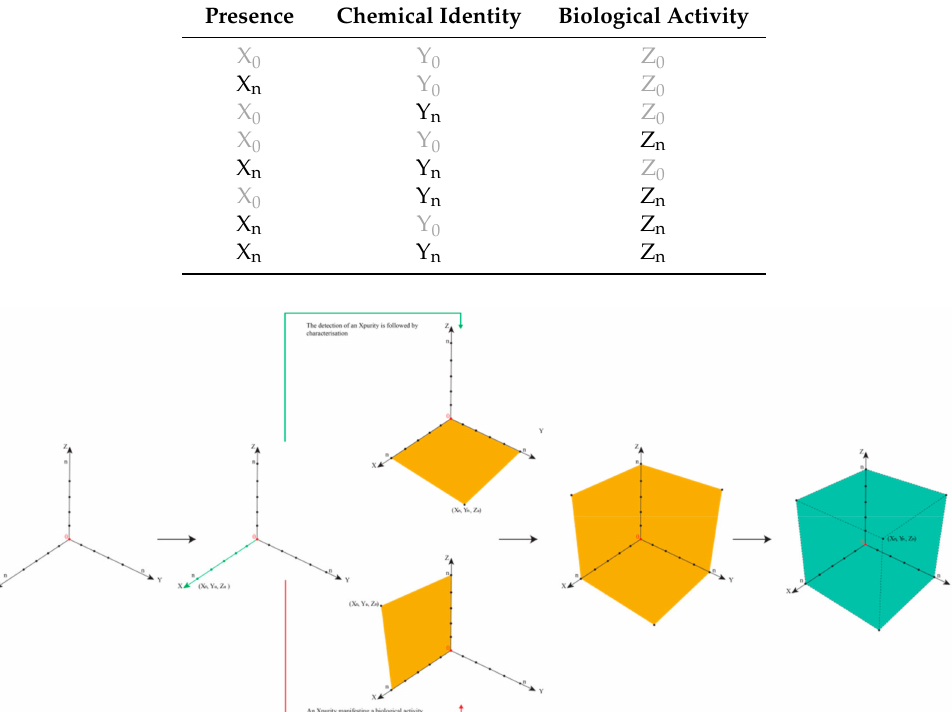
Figure 5. Illustration of the location of an Xpurity within the Cartesian Space of Information. After the detection of an Xpurity in a pharmaceutical product, three major scenarios are possible. The first would concur with the risk management approach and assume that since the presence of this Xpurity is below the identification threshold, it constitutes no danger for patients. The second would be the risk-free option of characterizing this Xpurity regardless of a threshold as indicated by the green arrow. The third scenario, indicated by the red arrow, represents a devastating event (i.e., the presence of a toxic Xpurity manifesting itself by serious side e ff ects in patients). The transition from the state of gathering information i.e., the presence, chemical structure and biological activity about an Xpurity, is represented by the Space of Information changing its colour from yellow to